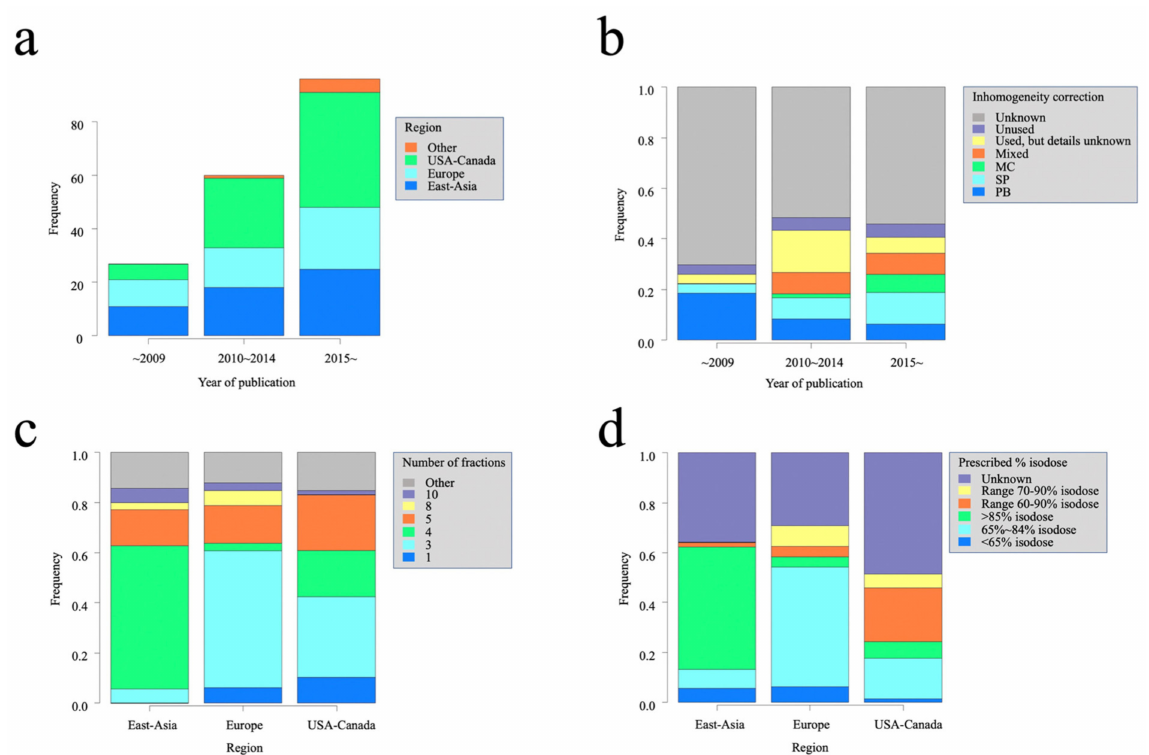
Figure 2. Characteristics of SBRT by region and year of publication. ( a ) Number of reports by year of publication, ( b ) use of inhomogeneity correction by year of publication, ( c ) number of fractions by region, and ( d )prescribedpercentisodosebyregion. Abbreviations: MC=MonteCarloorAcurosXB;SP=superposition, anisotropic analytical algorithm, or collapsed cone convolution; PB = pencil beam